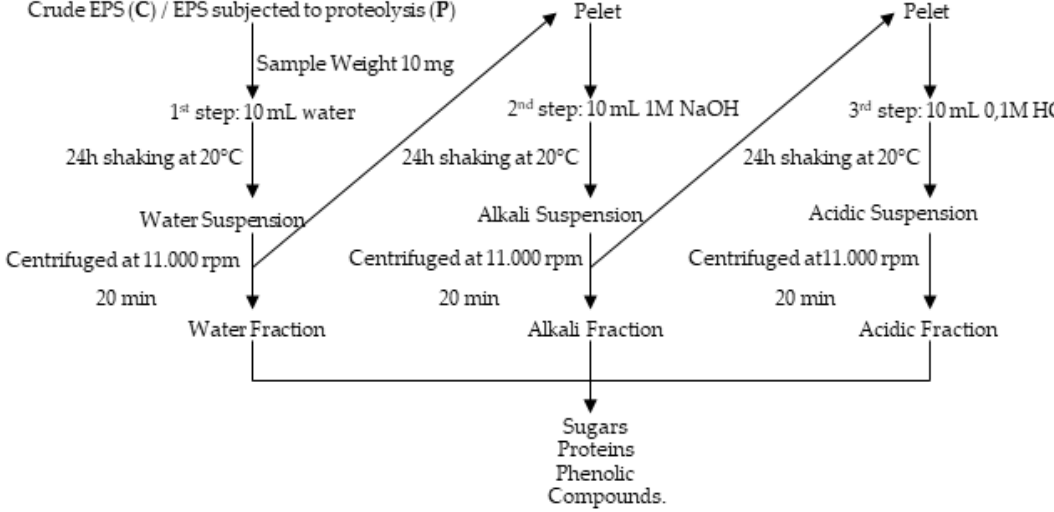
Figure 16. Scheme of fractionation of crude EPS (C) and EPS subjected to proteolysis (P) obtained from three F. culmorum strain cultures.